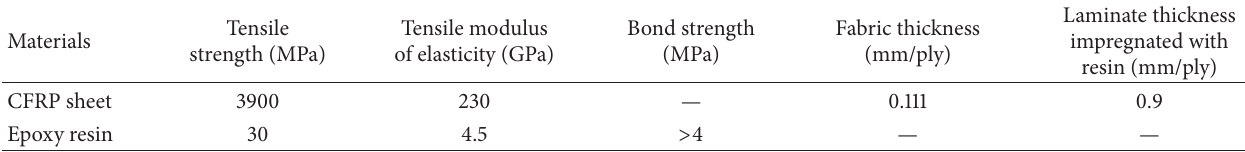
Figure 4: Typical failure of strut in RC deep beams with 𝑎/𝑑 = 0.75 : (a) ordinary RC deep beam, (b) CFRP-strengthened RC deep beam. Table 1: Typical properties of CFRP sheets and epoxy.